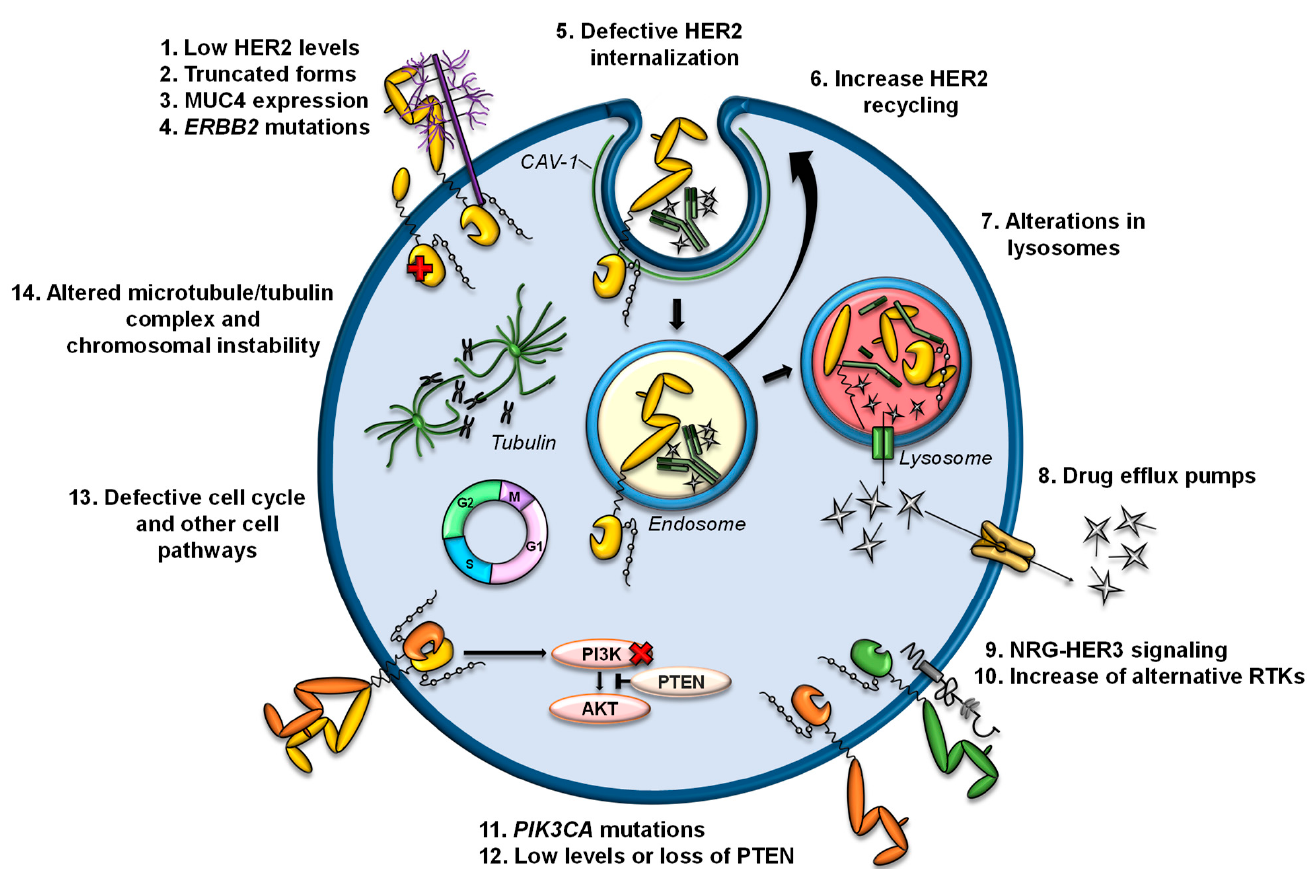
Figure 3. Potential mechanisms of resistance to anti-HER2 ADCs. The mechanisms of resistance to anti-HER2 ADCs are numbered and illustrated. Detailed descriptions are presented in the text.